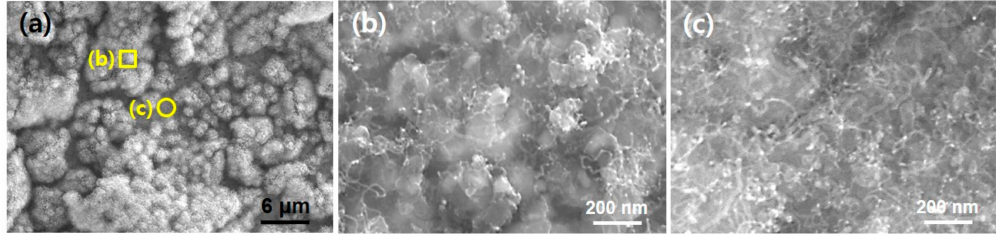
Figure 3. ( a ) Large area SEM view of Inconel 600 substrate surface after 5 s growth of CNT; ( b ) and ( c ) are high magnification SEM images showing di ff erent amount of CNT grown.